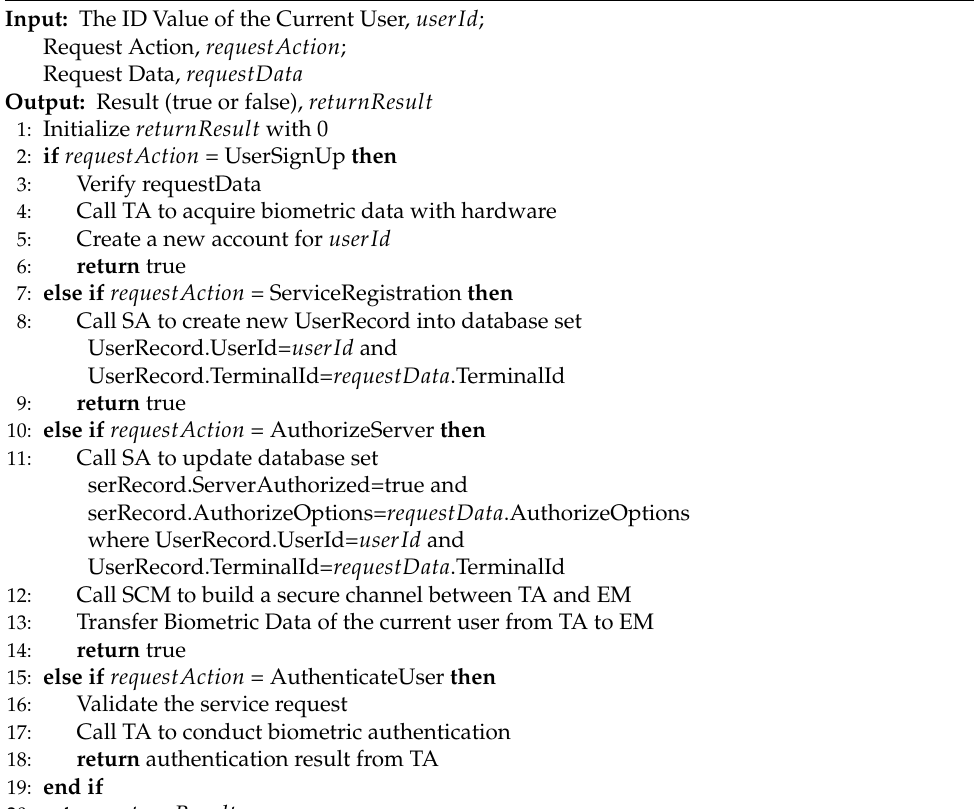
Algorithm 1 Request-Handling Process in User